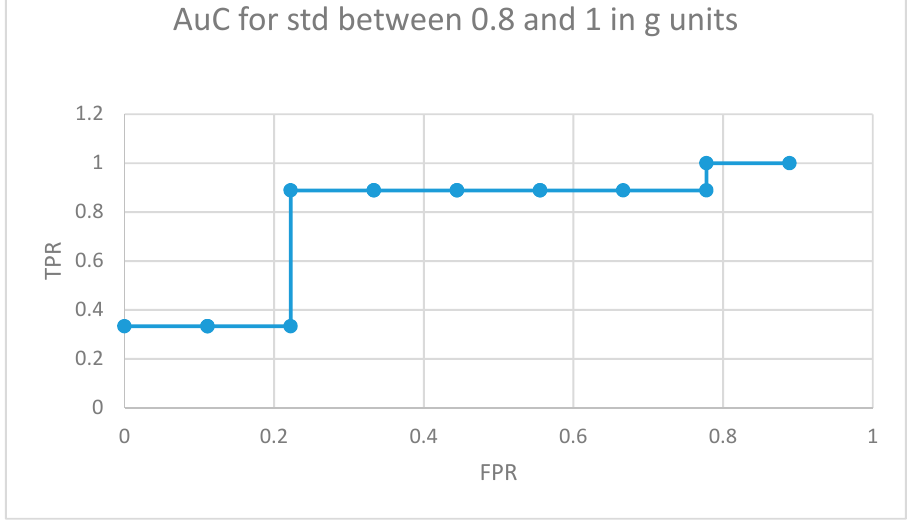
Figure 8. AuC for non-medicated participants with ADHD for movement fragments with the combined standard deviation between 0.8 and 1 in g units.